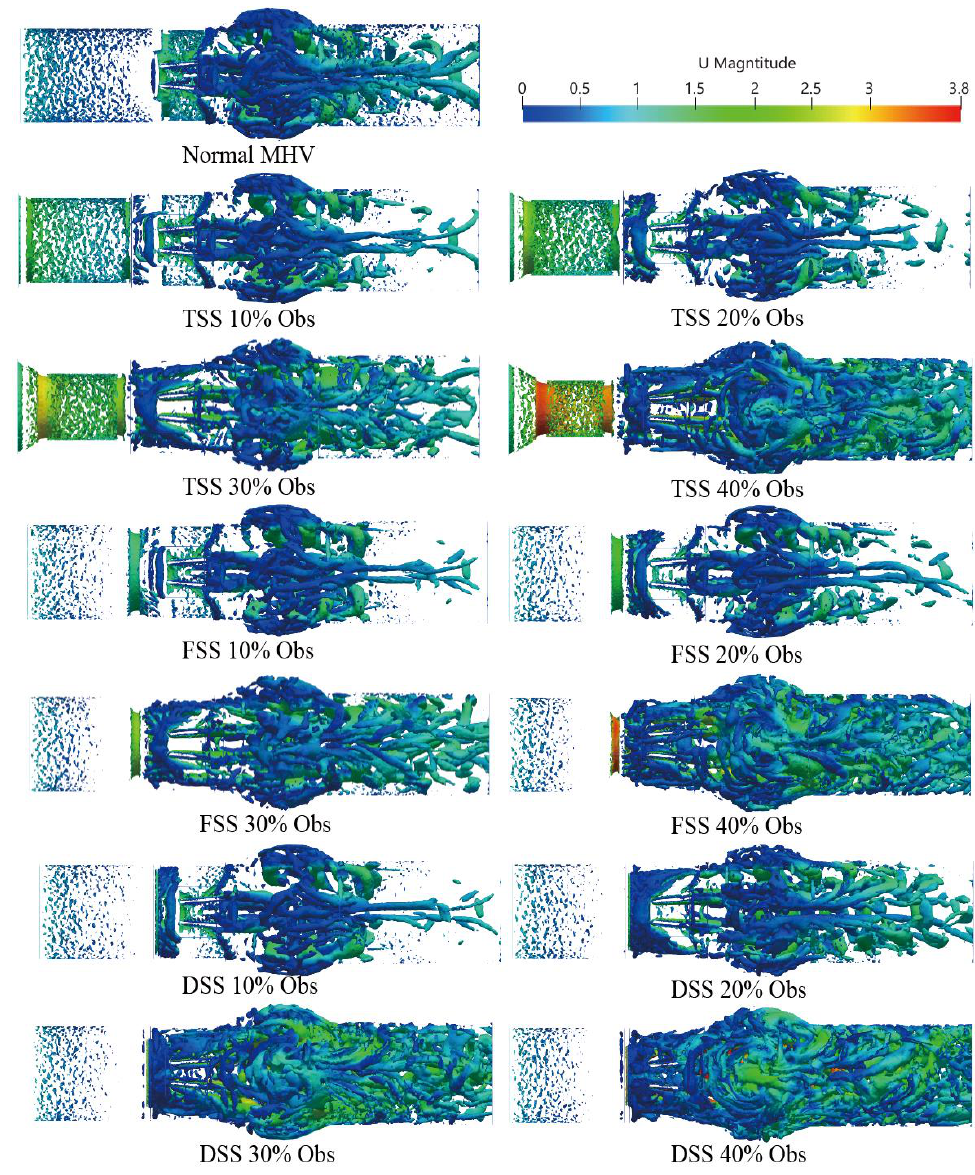
Figure 10. Vortical structure determined by the Q-criterion (Q = 10,000), colored by velocity magni- tude, is obtained in three types of SAS in the peak flow phase ( t = 0.2 s).